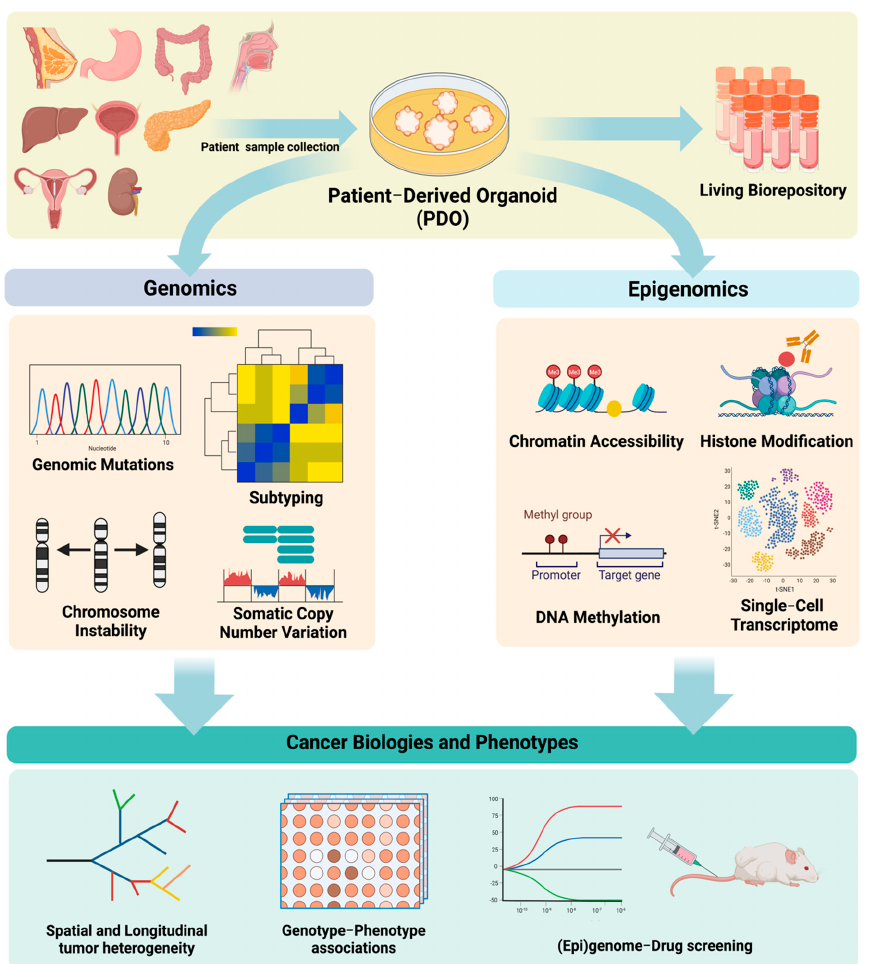
Figure 1. Genomic and epigenomic analyses of patient − derived tumor organoids and its application in cancer